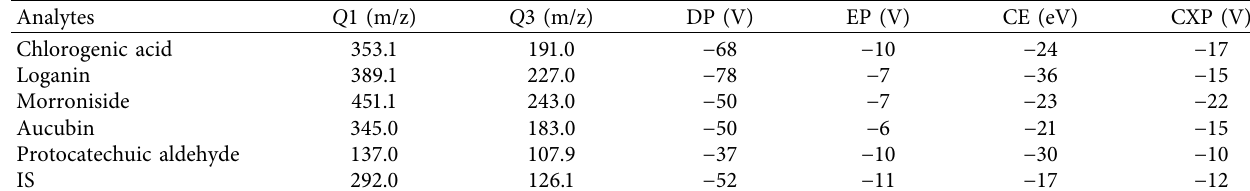
Table 1: Mass spectrometric parameters of 5 analytes and